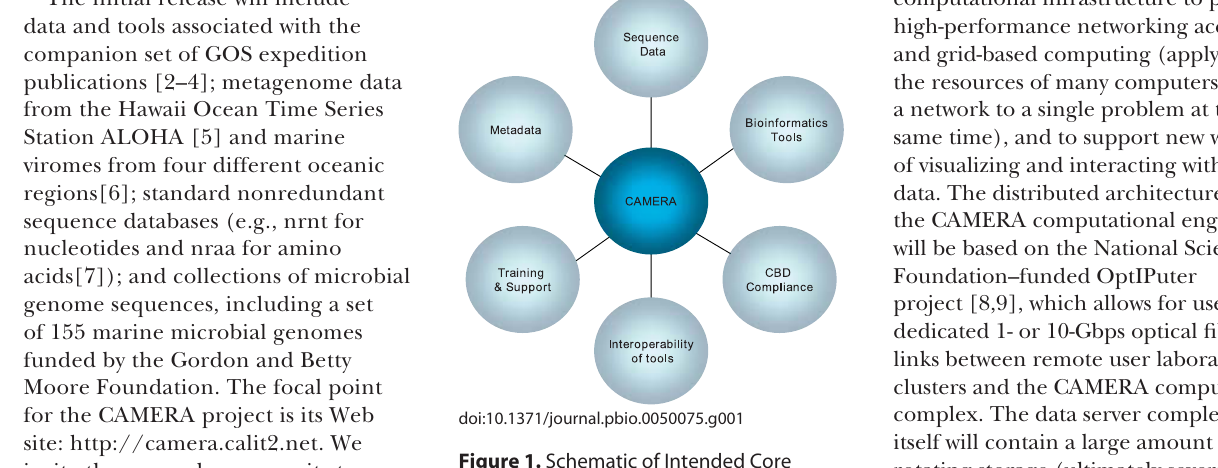
Figure 1. Schematic of Intended Core Functions of the CAMERA Project CBD, Convention on Biological